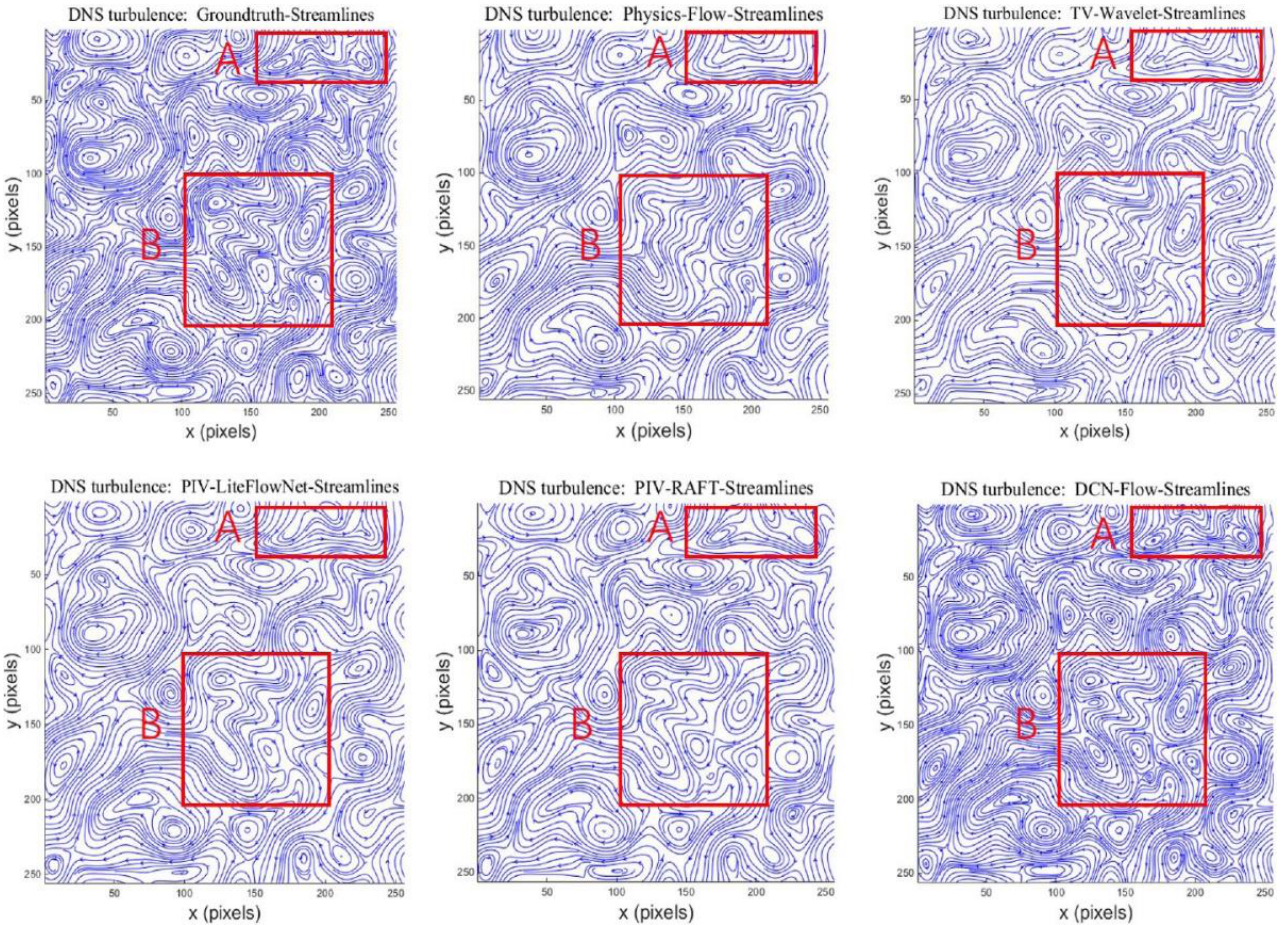
Figure 7. The streamlines of different motion estimators (Physics-Flow [38], TV-Wavelet Flow [39], PIV-LiteFlowNet [10], PIV-RAFT [11], and DCN-Flow) on an image pair from DNS-turbulent flow.